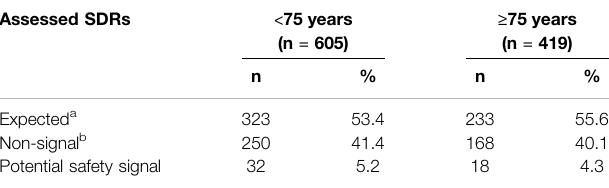
TABLE 2| Numberofassessed signals ofdisproportionalreporting byage